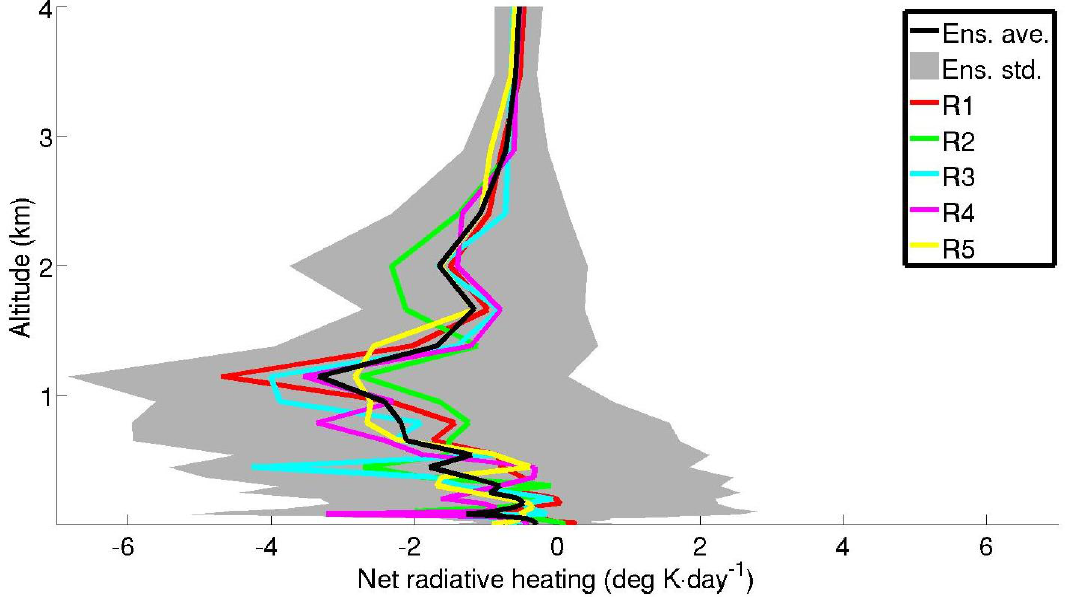
Figure 8. Vertical profiles of the modeled average net radiative heating (K day −1 ) for the ensemble average and all the members. Ensemble spread (± one standard deviation) is indicated by the gray-shaded